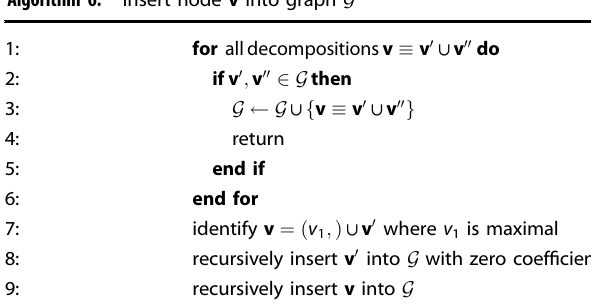
Algorithm 6. Insert node v into graph G